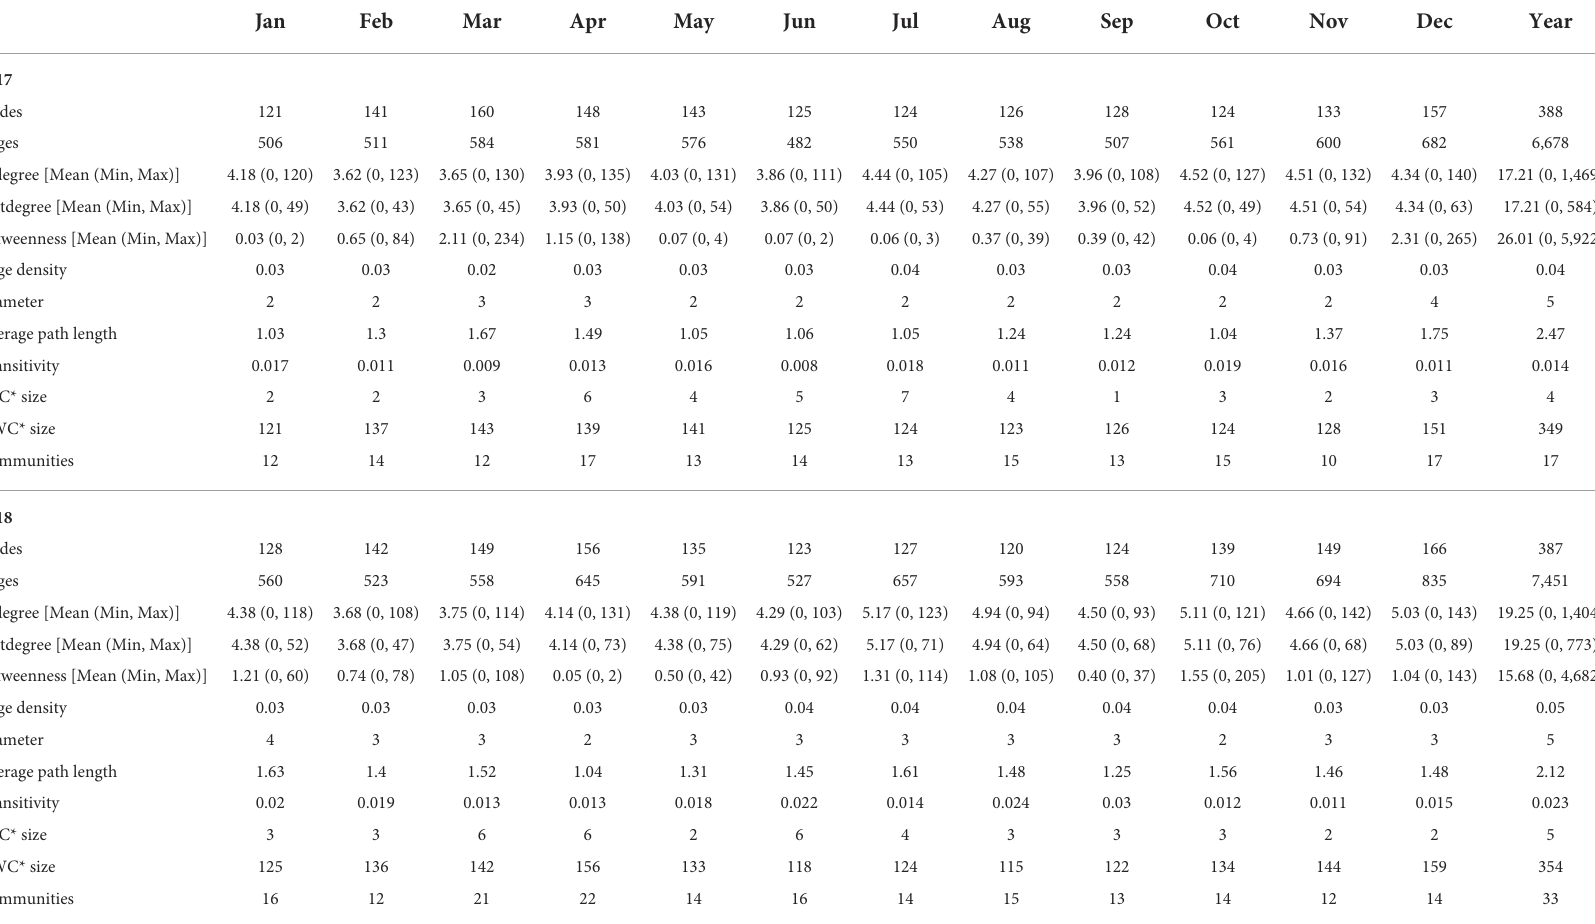
TABLE 2 North Macedonia live pig movement network parameters by month and year for